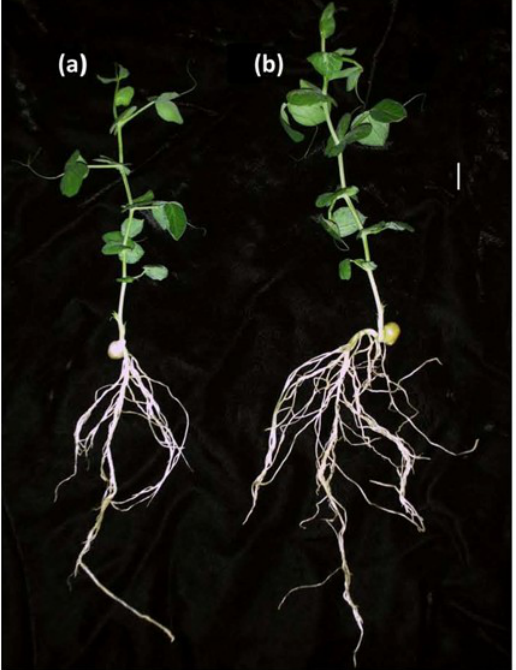
Figure 2. Change in pea root architecture for either (a) uninoculated plants or ( b ) plants inoculated with B. simplex 30N-5 and grown in a +N medium for 2 weeks, Bar, 1